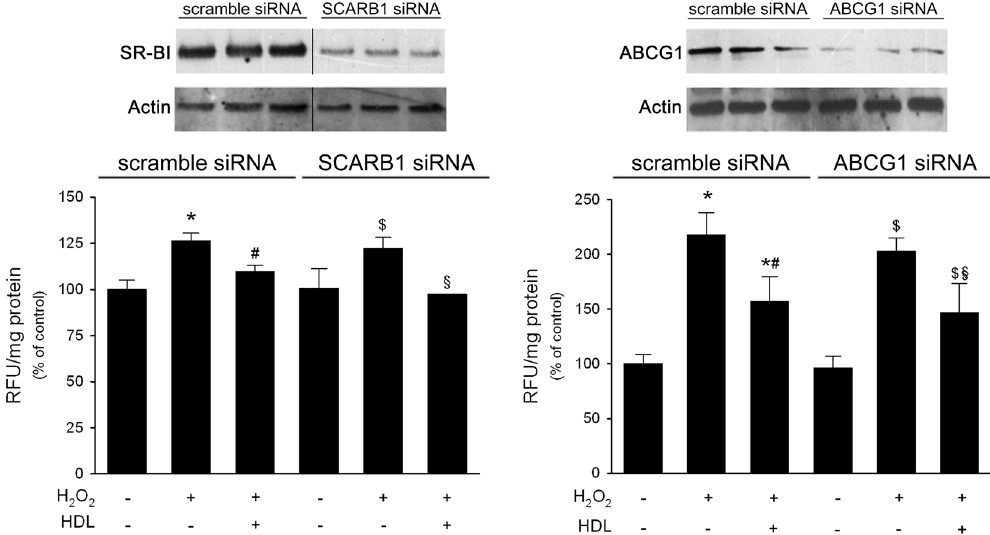
Figure 4. SR-BI and ABCG1 are not involved in HDL antioxidant effect. Panel A, SR-BI and ABCG1 protein levels in PC-3 cells treated with specific or control (scrambled) siRNA. Image of SR-BI blot has been manipulated to eliminate empty lanes between control and SCARB1 siRNA samples and to show 3 bands/ group as the original non manipulated blot for ABCG1. Images come from the same blots and same exposures. Original images of SR-BI are reported in Fig. S5. Panel B, ROS levels in H 2 O 2 -stimulated PC-3 cells pre-treated with specific or control (scrambled) siRNA. The effect of the co-incubation of 0.5 mM H 2 O 2 with 0.5 mg/ ml HDL for 1 h was tested. ROS production was evaluated by fluorescence. Data are expressed as relative fluorescent units (RFU) normalized by the protein concentration of total cell lysate, mean ± SD, n = 3. * P < 0.05 vs control cells incubated with scrambled siRNA, # P < 0.05 vs H 2 O 2 -stimulated cells incubated with scrambled siRNA, $ P < 0.05 vs control cells incubated with ABCG1 or SCARB1 siRNA, § P < 0.05 vs H 2 O 2 -stimulated cells incubated with ABCG1 or SCARB1 siRNA.